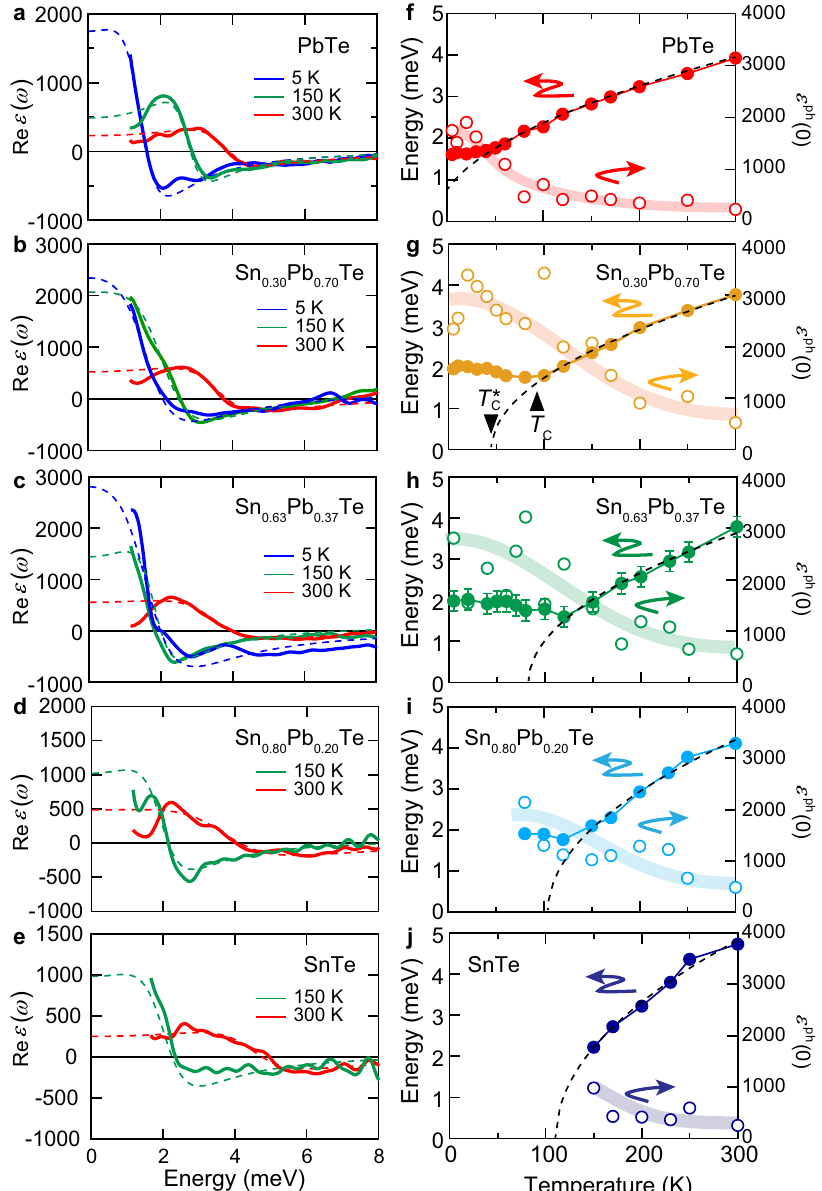
Fig. 4 Terahertz phonon dynamics. a – e Selected terahertz in-plane dielectric spectra Re ε ( ω ) for Sn x Pb 1 − x Te ( x = 0, 0.30, 0.63, 0.80, and 1). The dotted curves are fi ts with Re ε ph ( ω ) in Eq. (2). f – j Temperature dependence of the TO phonon energy ω T obtained from fi ts with Eqs. (1) and (2) ( fi lled circles) and DC dielectric constant arising from the soft TO phonons Re ε ( ω = 0) (open circles). The dotted curves represent the Curie Weiss law. The de fi nitions of T C* and T C are indicated in ( g ) as an example. The thick curves are the guide to the eyes. The error bars in ( h ) is roughly estimated from the width of arti fi cial fringe in